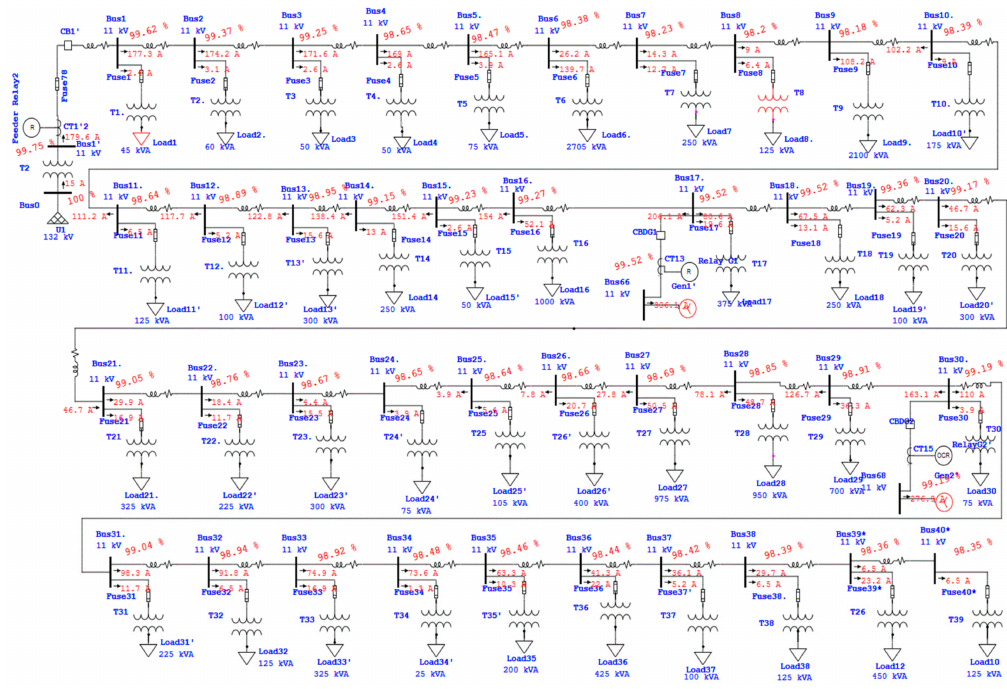
Figure 8. Load flow analysis through